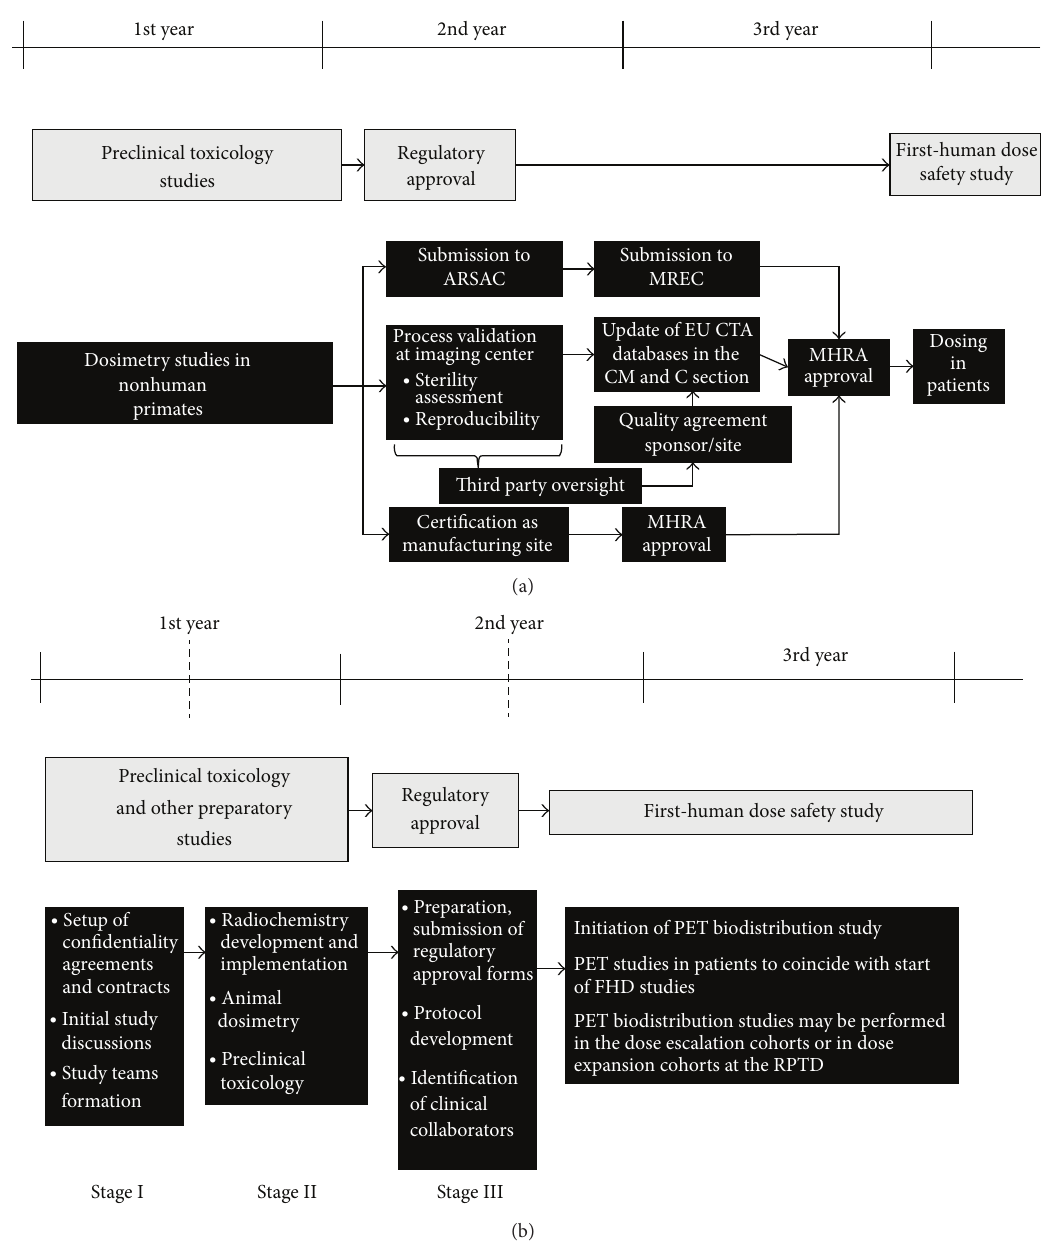
Figure 1: Summary of timelines and procedures performed in the PET biodistribution study of the ASO LY2181308 in relation to the FHD study (a). (b) Is proposed flowchart of future streamlined timelines of PET biodistribution studies in relation to FHD oncology studies with